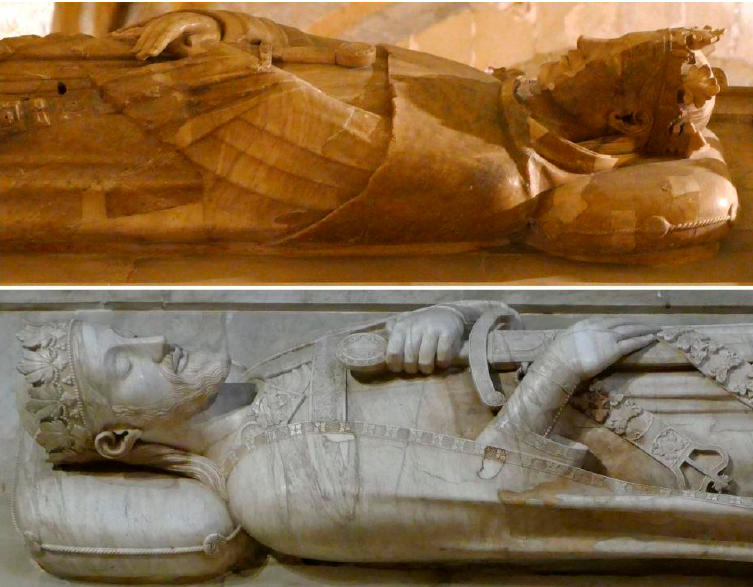
Figure 5. Monastery of Santa María de Poblet. James I as king and as monk, recumbent effigies which show the concept of Rex et Sacerdos . They were commissioned by Peter IV in the second half of the 14th century and restored in the 20th Century: the darkest parts are original; the lighter parts are reconstruction by the sculptor Frederic Marès. © Santa María de Poblet. Photo: Marta Serrano Coll. Permission granted.